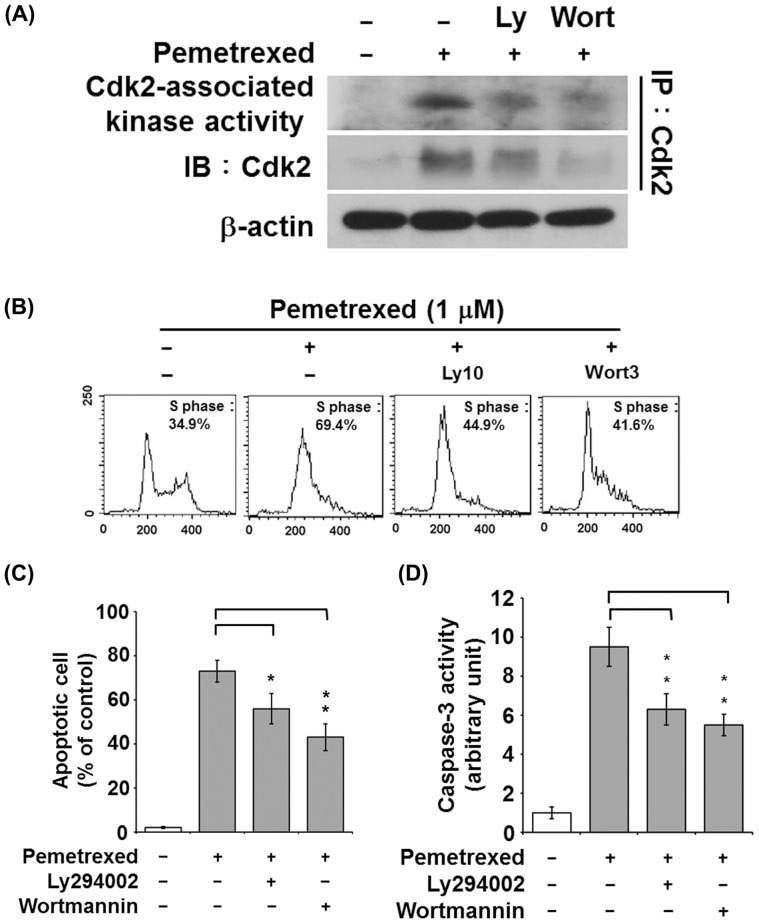
Pharmacological inhibition of Akt reduced pemetrexed-mediated Cdk2 activation, S-phase arrest and apoptosis in H1299 cells.Cells were pre-treated with wortmannin or Ly294002 for 2 h, and then treated with 1 µM pemetrexed, (A) the Cdk2 kinase activity and protein level were examined and (B) cell cycle distribution analysis was performed after 24 h treatment; (C) apoptotic cells and (D) caspase-3 activity were estimated after 72 h pemetrexed administration.